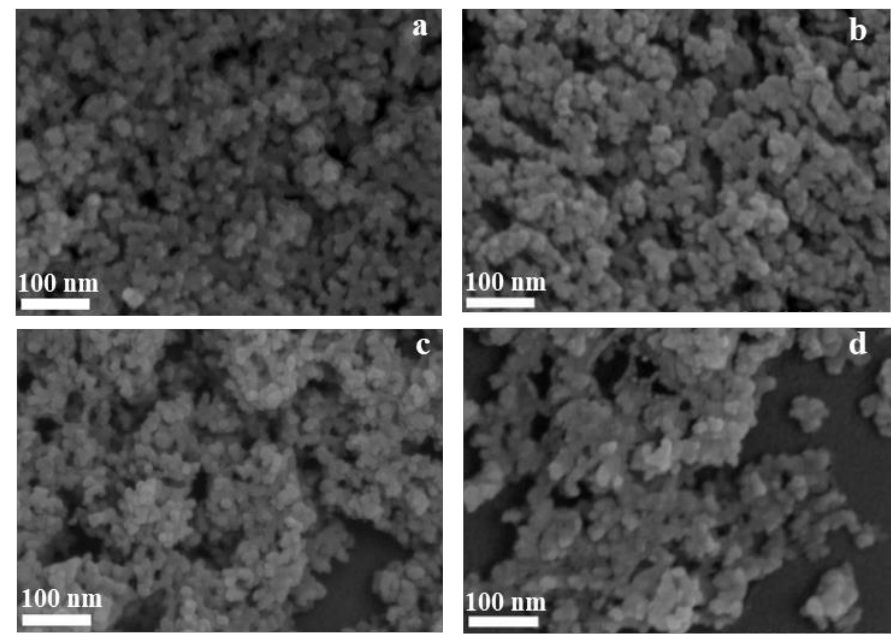
Figure 2. SEM images of ( a ) A-BFO; ( b ) T-CBO/A-BFO (1:2); ( c ) T-CBO/A-BFO (1:1); ( d ) T-CBO/A-BFO (2:1).